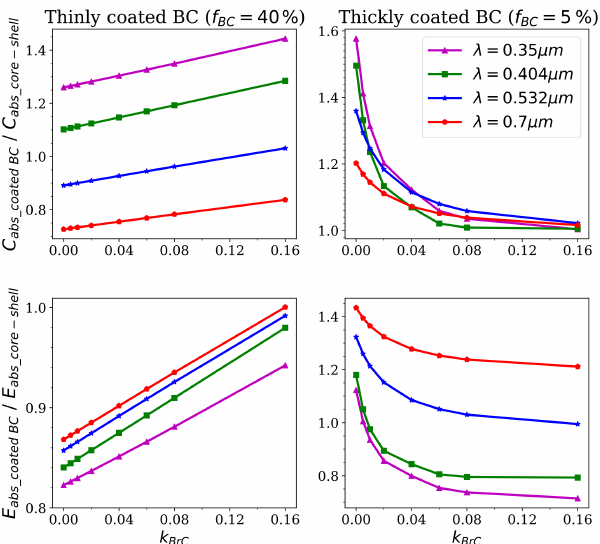
Figure 3. Effects of k BrC on the applicability of core–shell sphere ( n s =